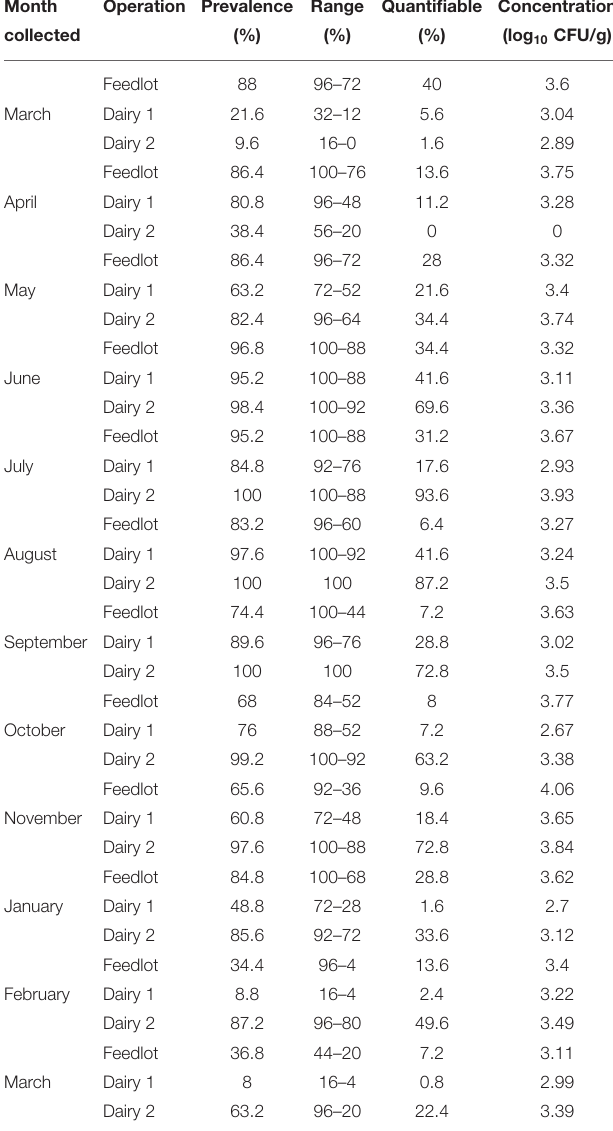
TABLE 2 | Comparison of prevalence, range, and pathogen load within and across operations by month of sample